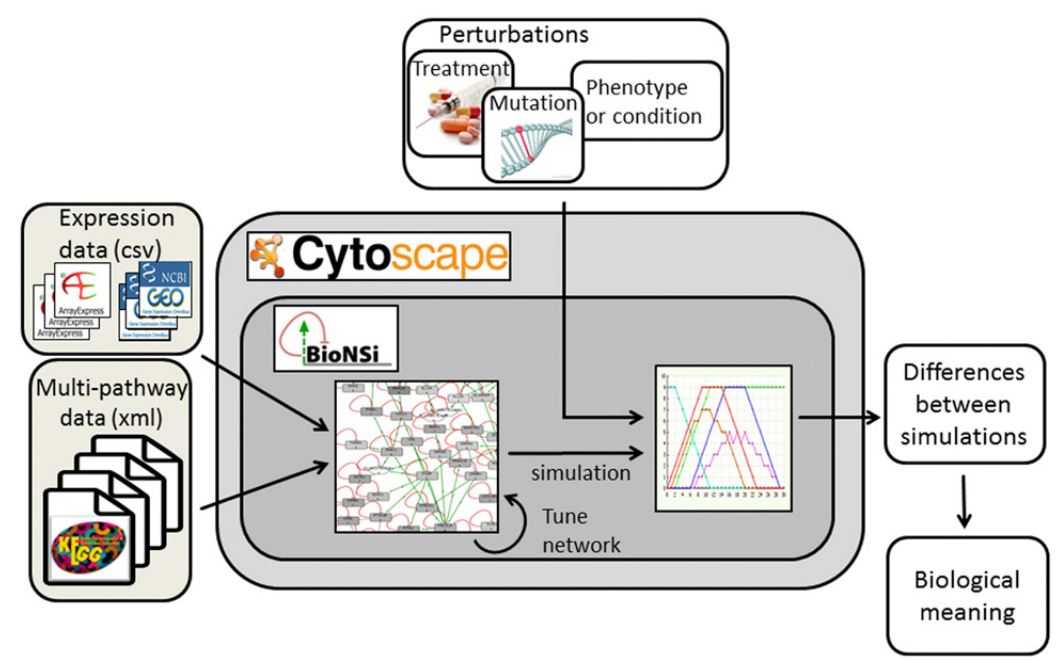
Figure 1. The extended BioNSi simulation tool. Gene expression data and selected KEGG pathway data-files are uploaded to BioNSi’s Cytoscape Application and analyzed. The resulting network can be modified and tuned. Simulation is performed for gene expression data resulting from various conditions, possibly with addition of artificial perturbations. Differences in the results of simulation under various conditions provide novel biological